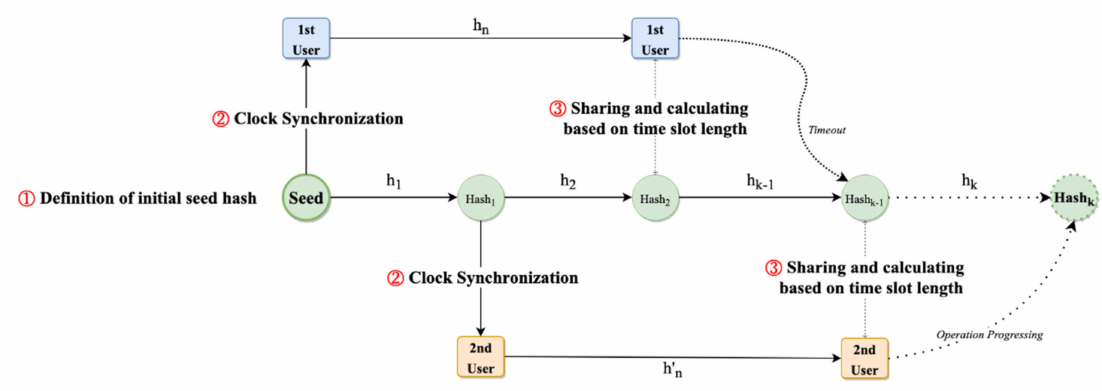
Figure 3. Authentication and verification